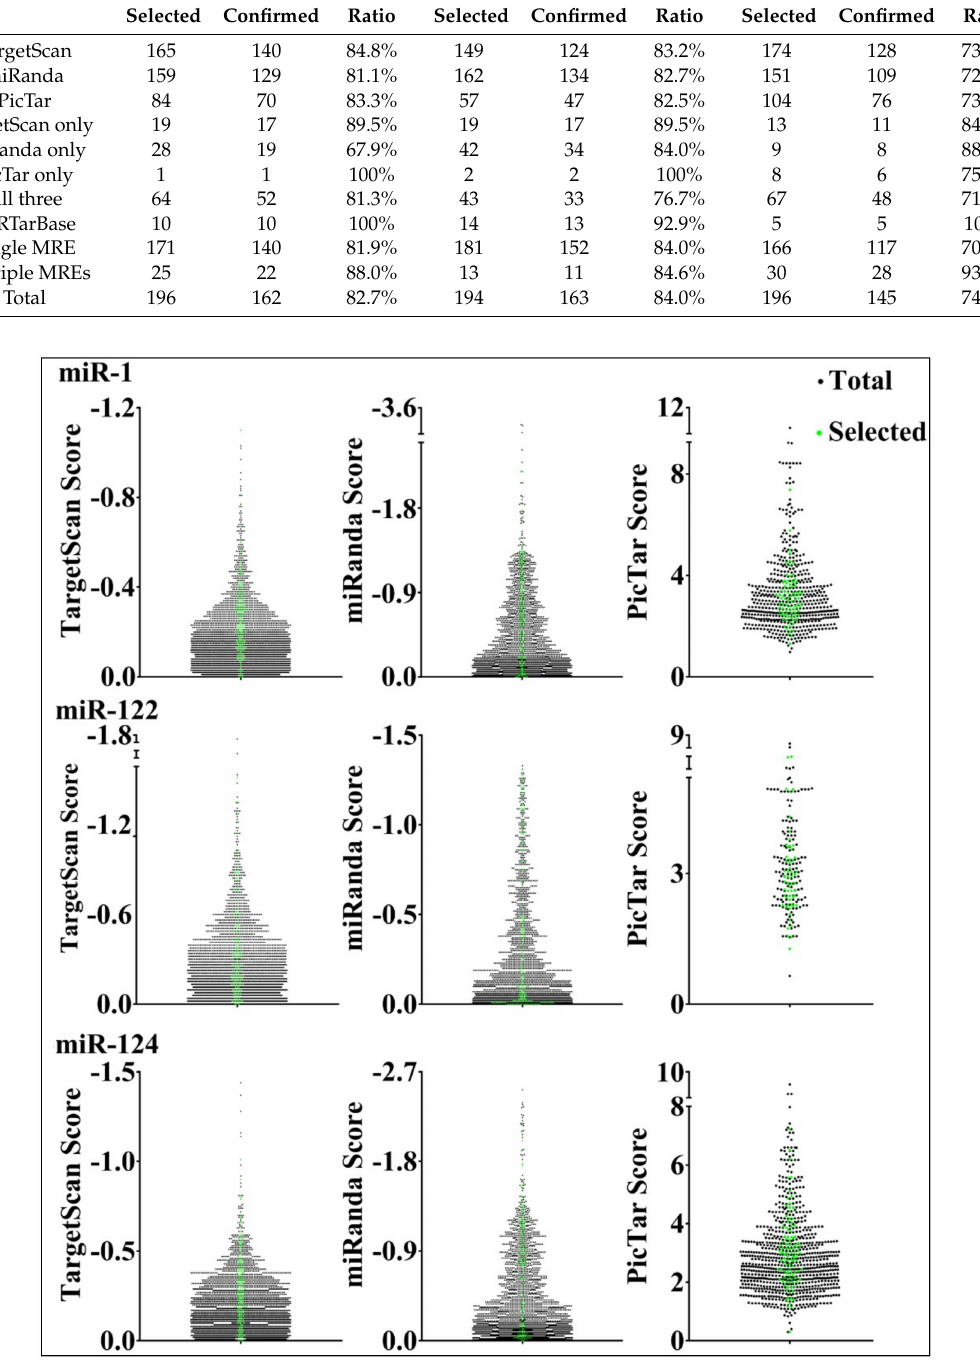
Figure 1. Selection of predicted miRNA target genes. Ranking scores provided by TargetScan, miRanda, and PicTar are shown in the y -axes. Black dots denote all the predicted genes, and green dots the ones chosen for